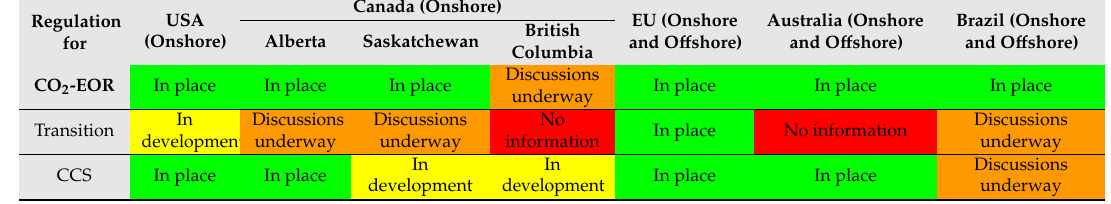
Table 5. Overview of the regulatory status of selected countries / regions (after [39]) with indications of where the reviewed regulations